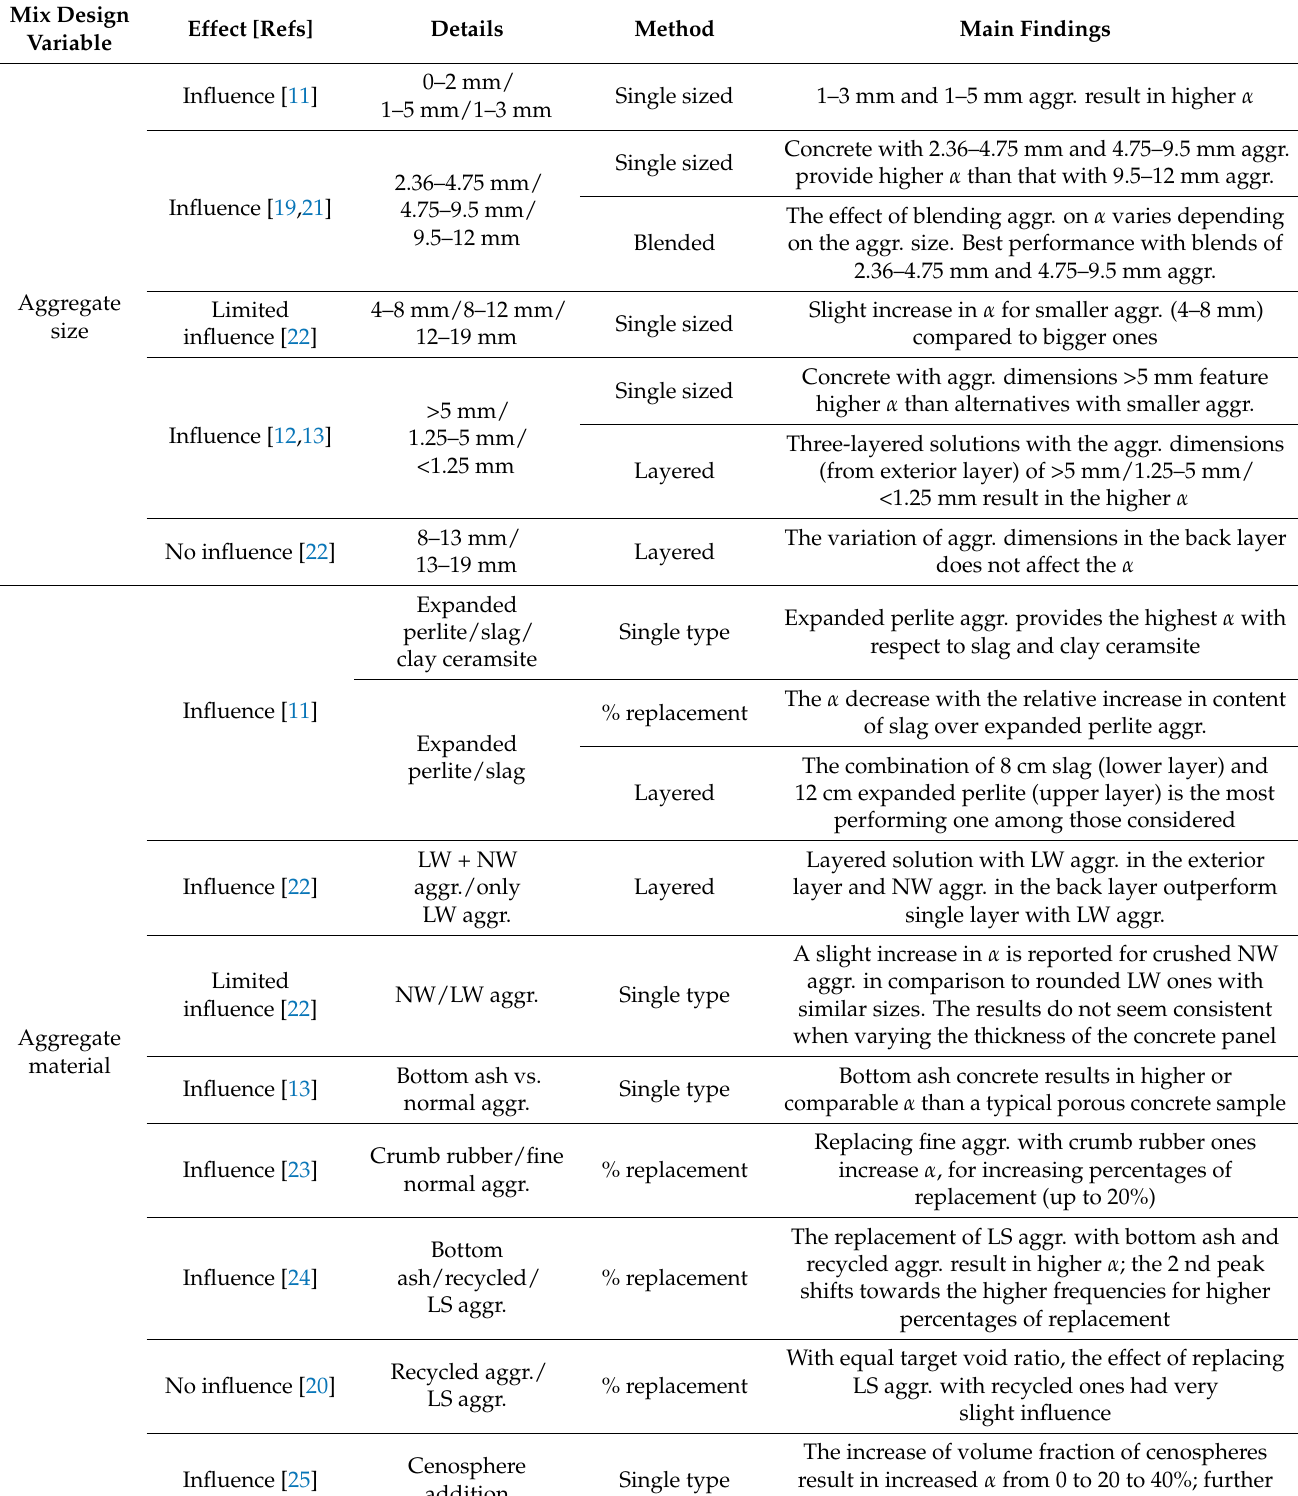
Table A1. Summary of the main findings of past studies on the effect on sound absorption of aggregate size, dimensions and type, and panel thickness. Abbreviations used in the table body: lightweight (LW); normal weight (NW); limestone (LS); aggregate (aggr.); sound absorption ( α